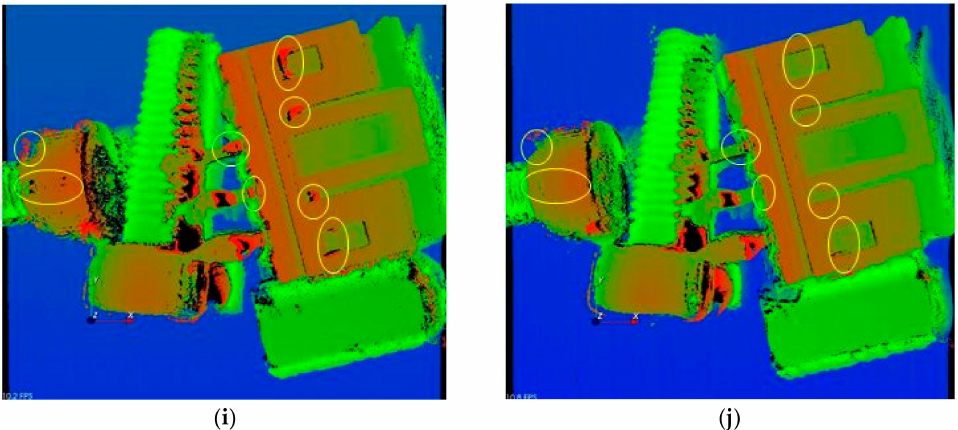
Figure 15. Measurement results of mixed industrial parts: ( a ) mixed industrial parts; ( b ) captured image without fringe; ( c ) captured image with fringe pitch 121; ( d ) captured image with fringe pitch 12; ( e ) wrapped phase map of fringe pitch 121; ( f ) wrapped phase map of fringe pitch 12; ( g ) fringe-order map calculated using MFPS; ( h ) fringe-order map extracted using NCCMFPS; ( i ) 3D profile measured using MFPS; ( j ) 3D profile measured using